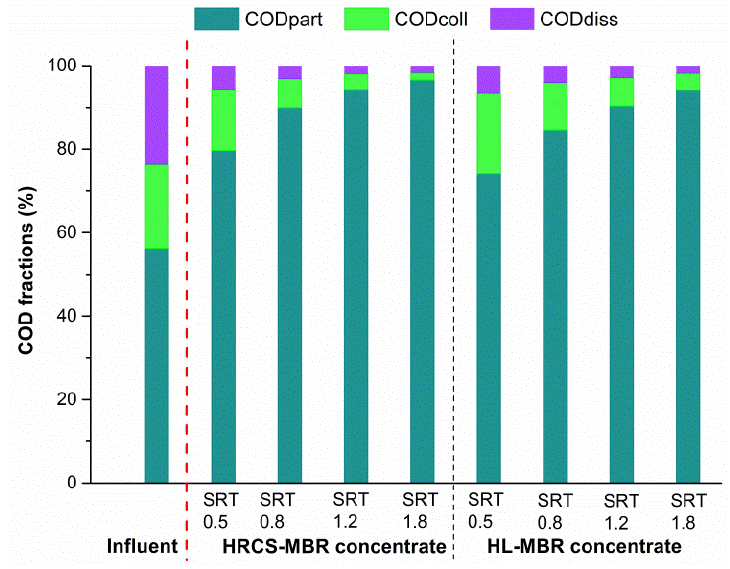
Figure 3. COD fractions in the wastewater and in both MBRs’ concentrate under different SRT conditions. The total COD consists three fractions: the particulate, colloidal, and dissolved COD (COD part , COD coll , and COD diss ).